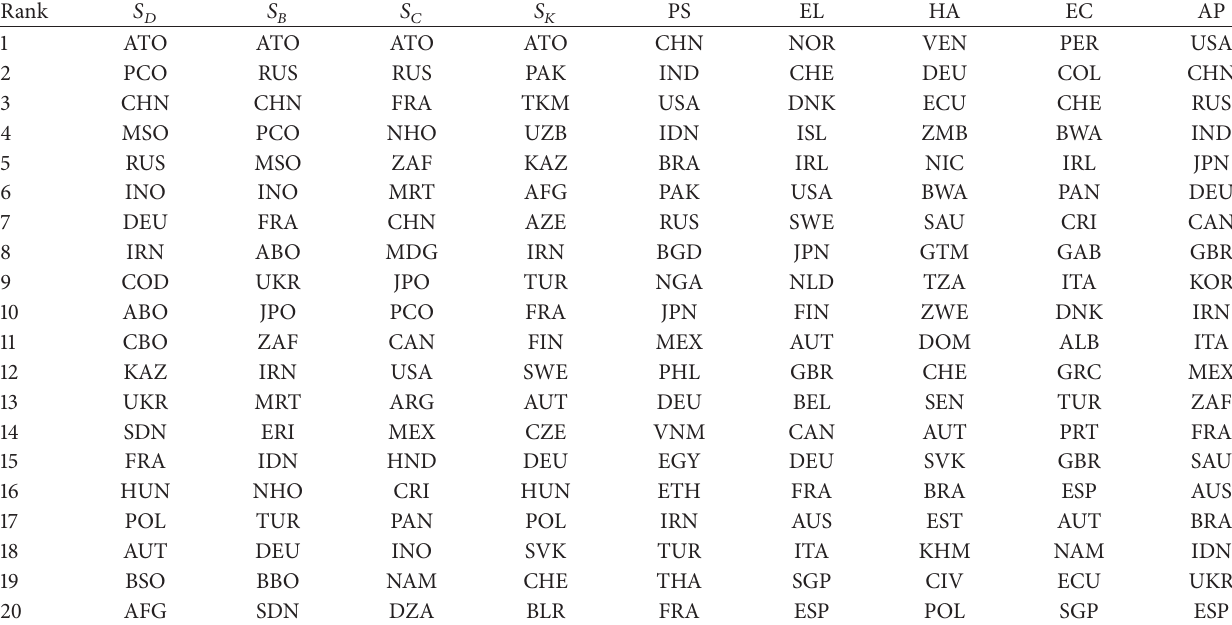
Table 2: Top 20 nodes of the static and dynamical properties.